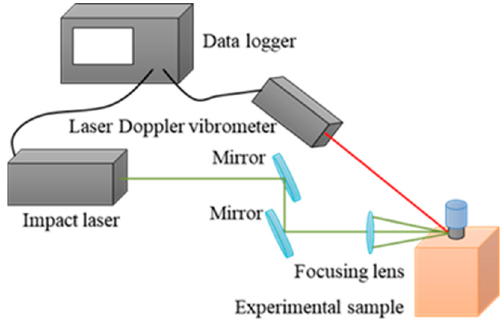
Figure 1. Experimental setup for L-RFA testing.